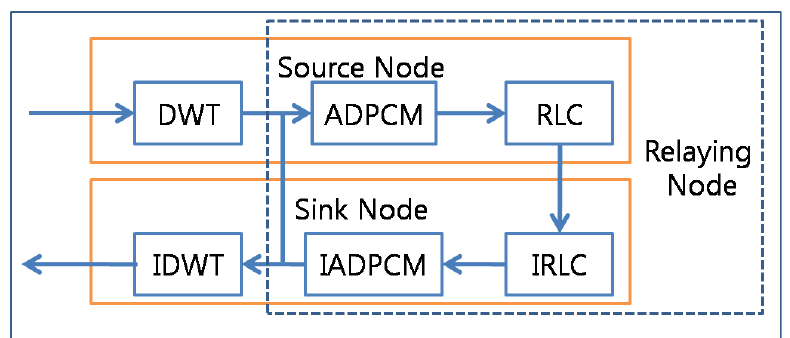
Figure 4. Data compression